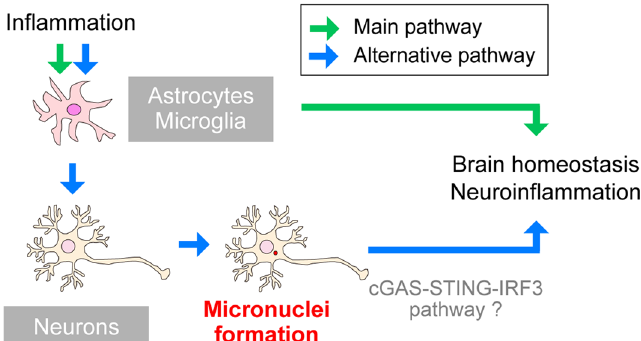
Figure 6. A model describing the pathways linking neuroinflammation to micronuclei formation. Inflammatory stimulations promote neuroinflammation via activating glia. Furthermore, inflammation produces micronuclei in neurons. Since micronuclei can activate the cGAS-STING pathway, micronuclei induced by the inflammatory response may act as a positive feedback pathway. Adobe Creative Could CC (Illustrator 25.0.1) (https:// www. adobe. com/) and Apple Keynote 11.0.1 (https:// www. apple. com/) were used for all illustration preparation in Fig.